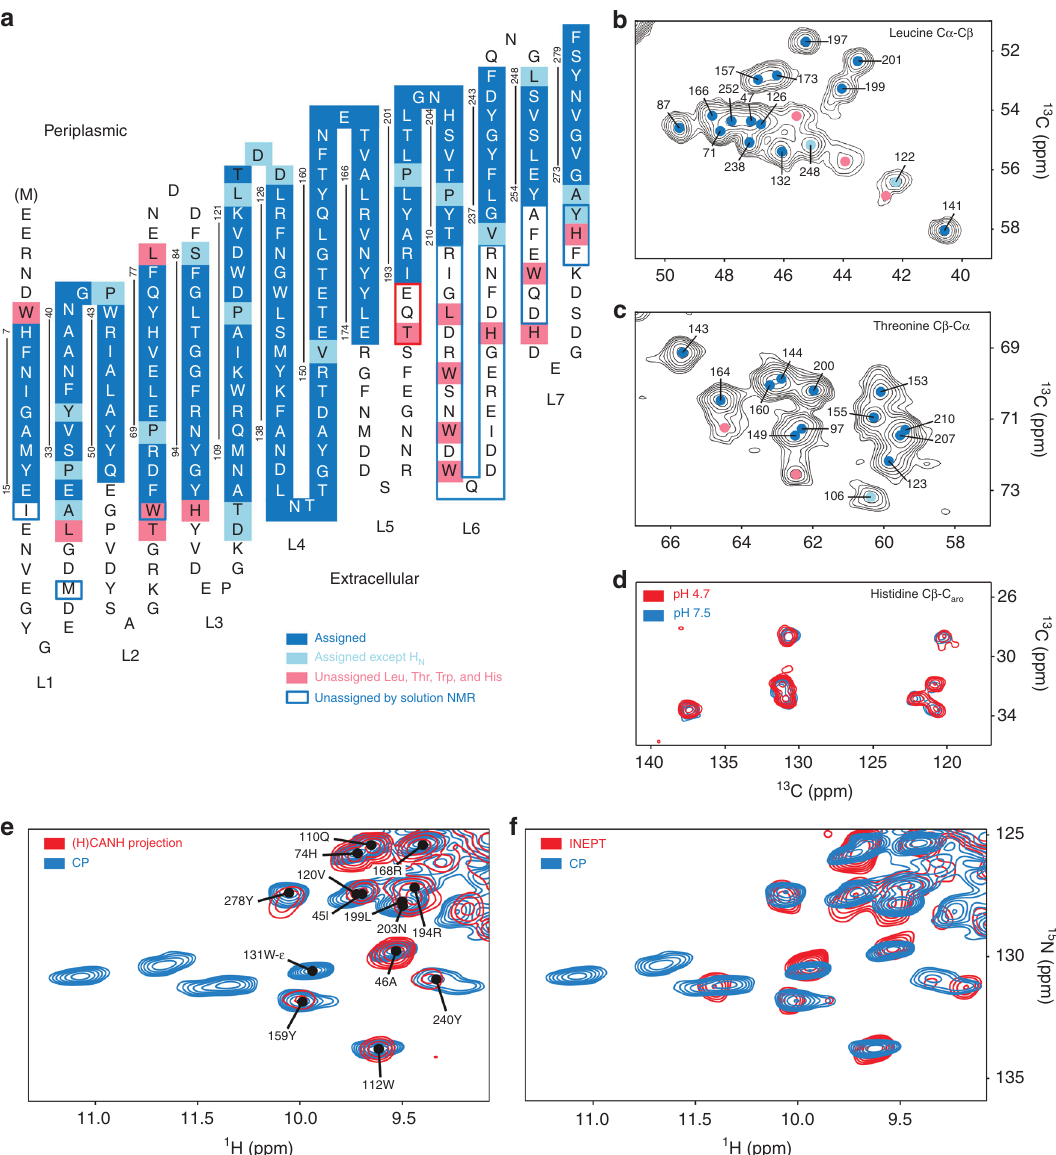
Fig. 1 Resonance assignment and OmpG topology. Assigned residues are indicated in blue. a For residues in light blue, the 1 H N shift is unknown but partial carbon assignment was obtained. Pink indicates unassigned residues as discussed in the text. Residues in blue frames do not show signals in solution NMR spectra and residues in the red frame were assigned by solution NMR but not solid-state NMR, see text. Vertical lines indicate the β -strands with residue numbers. b – d Spectral regions of 13 C – 13 C correlation spectra comprising C α – C β peaks of b leucine in the GAVLS(W) sample (20 ms DARR), c threonine in a DARR spectrum of the 1,3-TEMPQANDSG sample (50 ms mixing), and d histidine in a 50 ms DARR spectrum of the GANDSH(LV) sample. For the peaks indicated by pink dots in these 13 C – 13 C spectra, no strip could be found in the 1 H-detected 3D spectra. e , f Overlays of a CP-based 1 H – 15 N-correlation (blue) comprising the region of Trp side chain cross peaks with the projection of the CANH spectrum ( e ) and an INEPT-based HSQC ( f